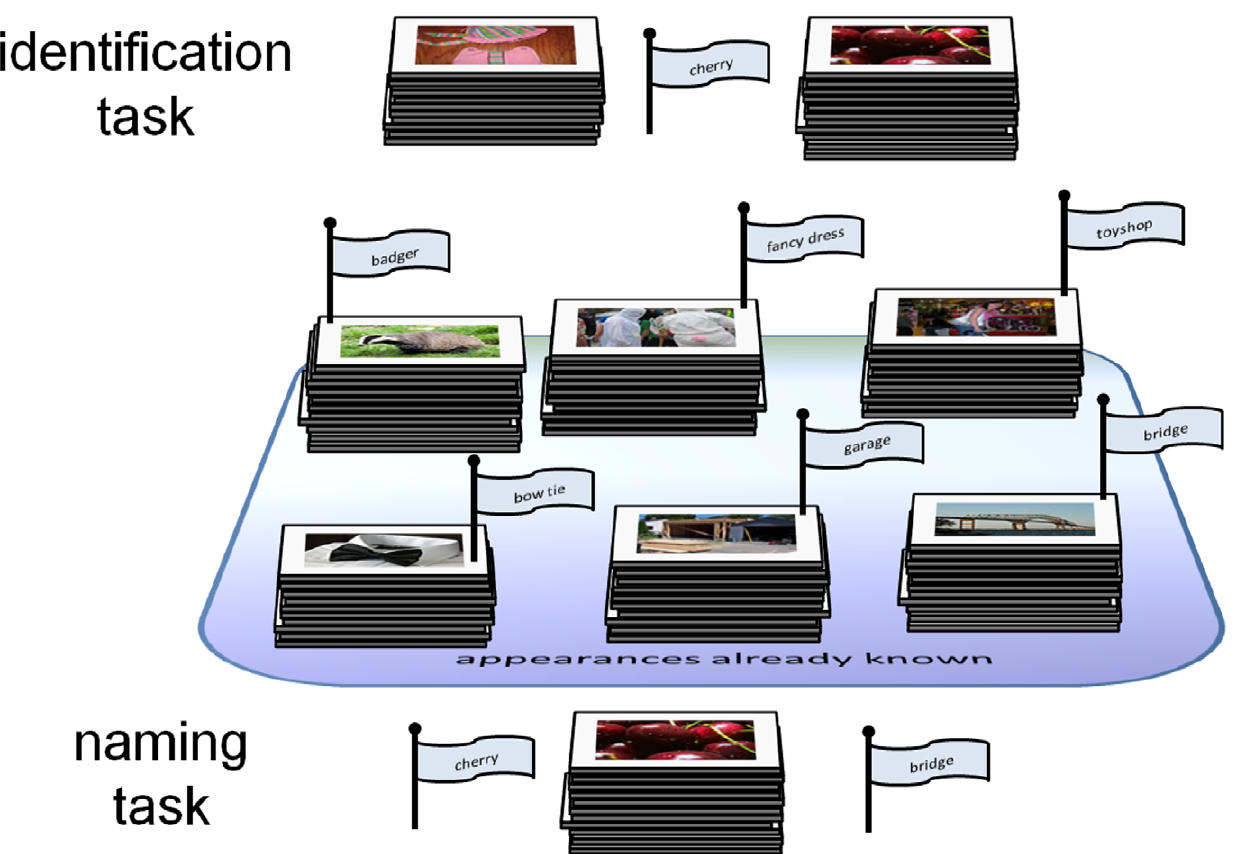
Figure 3. The identification and naming tasks. In our experiments, the appearance of a word is modelled using a set of images of examples of that word, which in the figure we illustrate as a pile of images. The identification task is to determine which of two unlabelled novel appearances should be paired with a word (in this case cherry) . The correct answer is on the right. The naming task is to determine which of two labels (in this case cherry and bridge ) should be paired with an appearance. The correct answer is cherry . In both types of task the system is provided with knowledge of the appearance of a set of words (in the figure six) disjoint from those involved in the task.